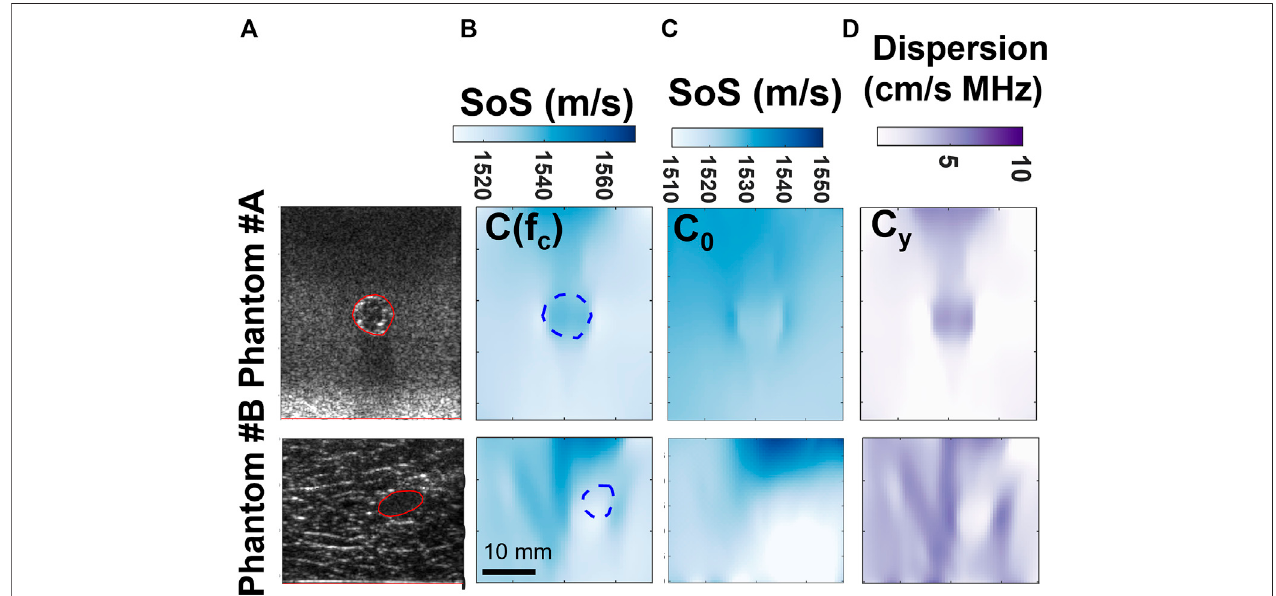
FIGURE 7 | Comparison of frequency-dependent SoS imaging for phantom and ex-vivo tissues, with columns from left to right (A-D) : B-mode image; c at the center frequency 5.2 MHz; reconstructed c 0 maps; reconstructed c y maps.